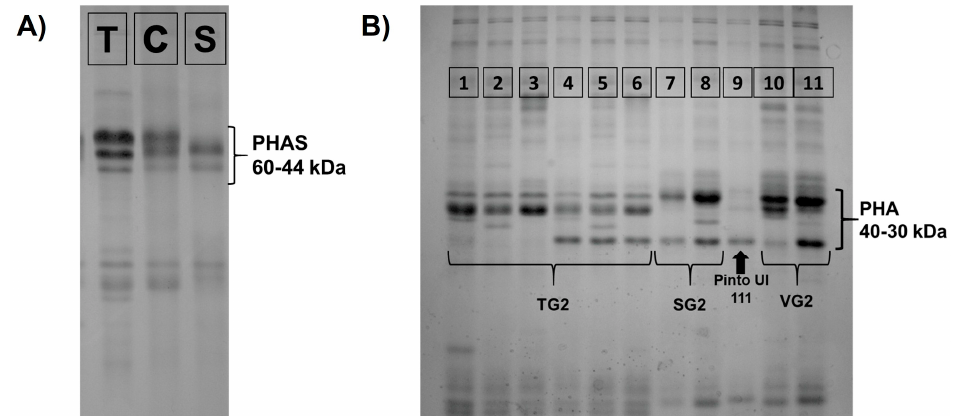
Figure 1 . PHAS and PHA protein patterns detected across the 66 common bean landraces in the Lazio region. ( A ) SDS–PAGE of PHAS protein fraction showing the T, C, and S types. ( B ) SDS–PAGE of the PHA protein fraction showing 11 different patterns, which can be divided into four major variant groups according to the nomenclature proposed by Brown et al. [67]: TG2, SG2, PintoUI111, and VG2.